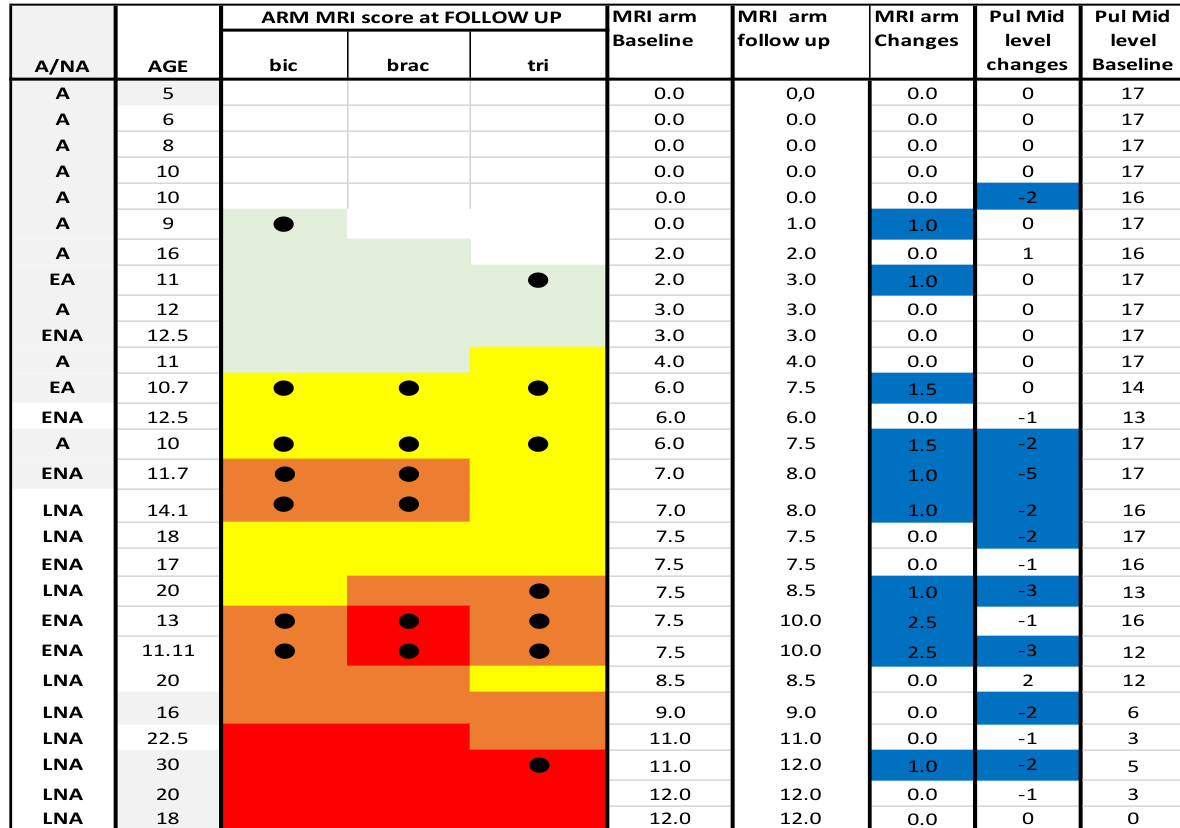
Figure 8. Detail of MRI and PUL at arm level. Individual details of imaging and PUL findings at arm level. The shading reflects the severity of involvement with the score of 0 shown as a white cell, score of 1 as pale green, score of 2 as yellow, score of 3 as orange and score of 4 as red. The grade 2.5 was used to identify patients with 2b involvement. Bic = biceps brachii; brac = brachialis;tri = triceps brachii; A= ambulant; EA = early ambulant; NA= non ambulant; ENA = early non ambulant; LNA: late non ambulant. ● Black circle means a higher Mercuri score respect to the baseline in the respective muscle. Blue line indicates changes in both MRI and PUL scores.